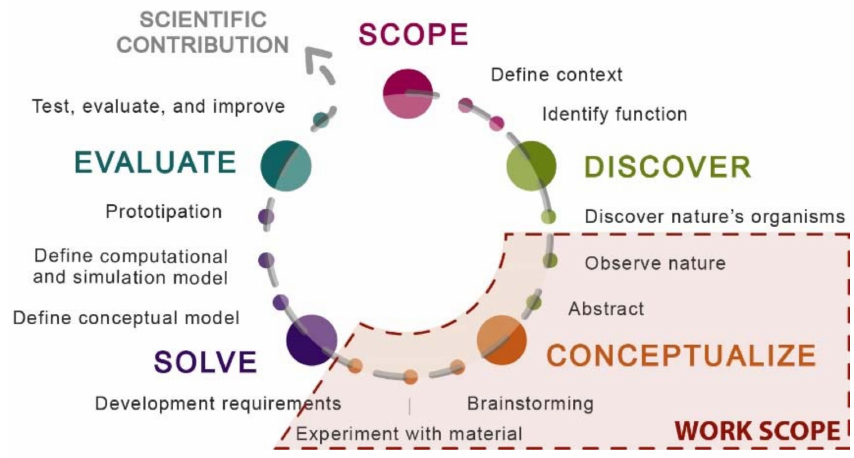
Figure 1. Research methodology. Source: